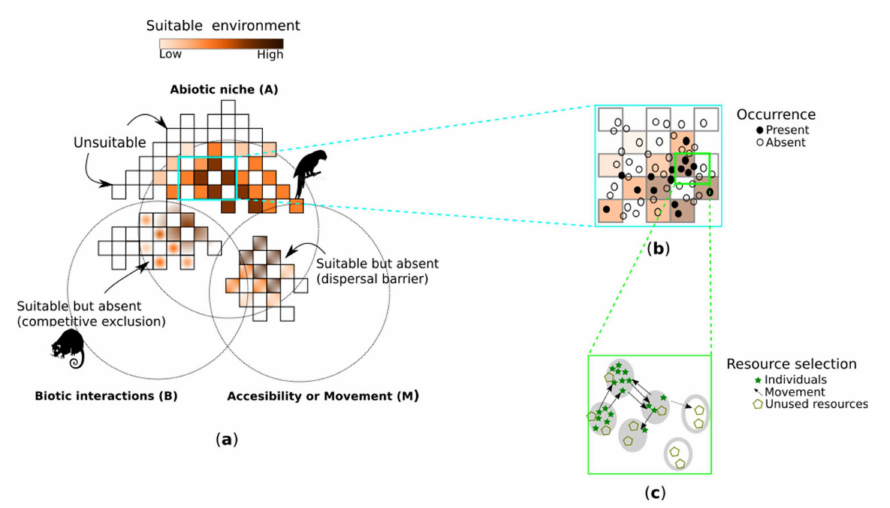
Figure 5. The main paradigms for modelling species distribution operate at different hierarchical levels, requiring different types of data and algorithms. ( a ) The niche modelling (ENM) paradigm predicts suitable environmental conditions where species might occur, but although suitable, this habitat cannot be used due to biotic relationships and dispersal barriers constraints. ENM can use presence-only datasets if algorithms such as Maxent, Random Forest, BIOMOD, and GARP are used, but will require “pseudo-absence” data if GLM methods are used instead. ( b ) State-observation models (SOM) work at the population level and predict the occupancy probability conditioned to the probability of detecting the species given it is present. SOM typically requires data from repeated sampling visits (occasions) to a single site during a time frame over which the population is closed (e.g., no changes in occupancy between surveys). ( c ) The Resource Selection Function (RSF) paradigm works at individual and species scales and predicts the probability of an animal or species using a certain resource, proportional to the availability of that resource in the environment. RSF requires two types of data: presence records of the focal species (either at individual or species level) and data on the resources available across the study